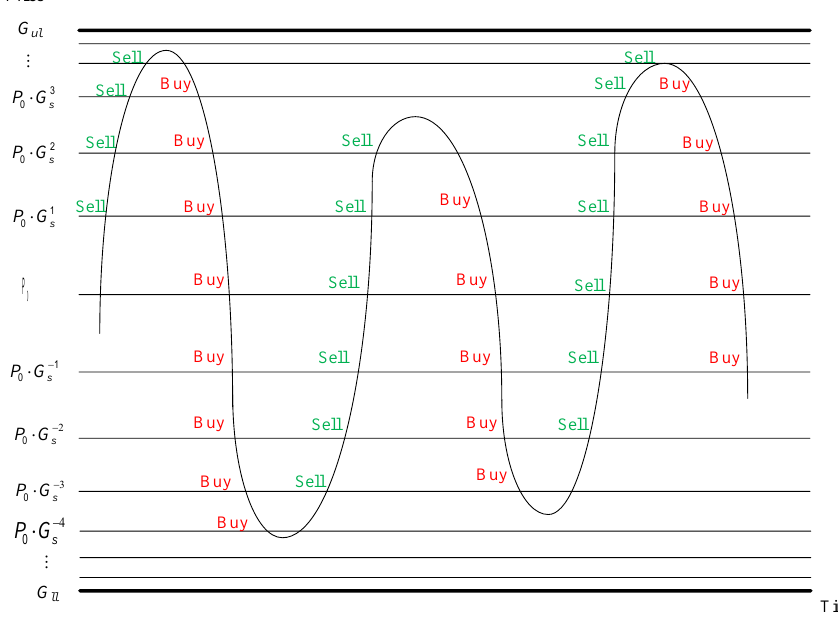
Figure 5. Schematic diagram of flexible grid trading.